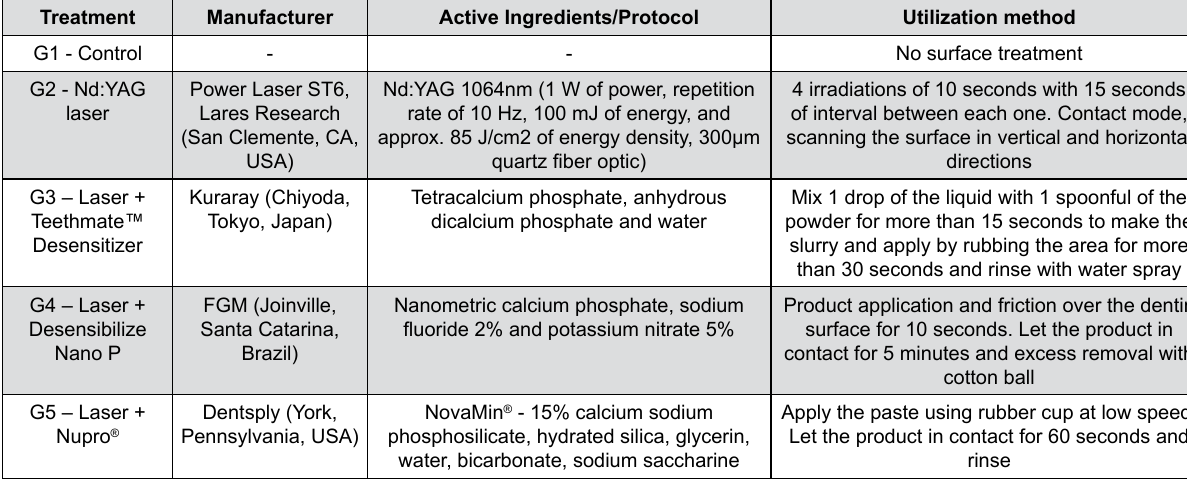
Figure 1- In-office desensitizing treatments: description of manufacturers, active ingredients and utilization